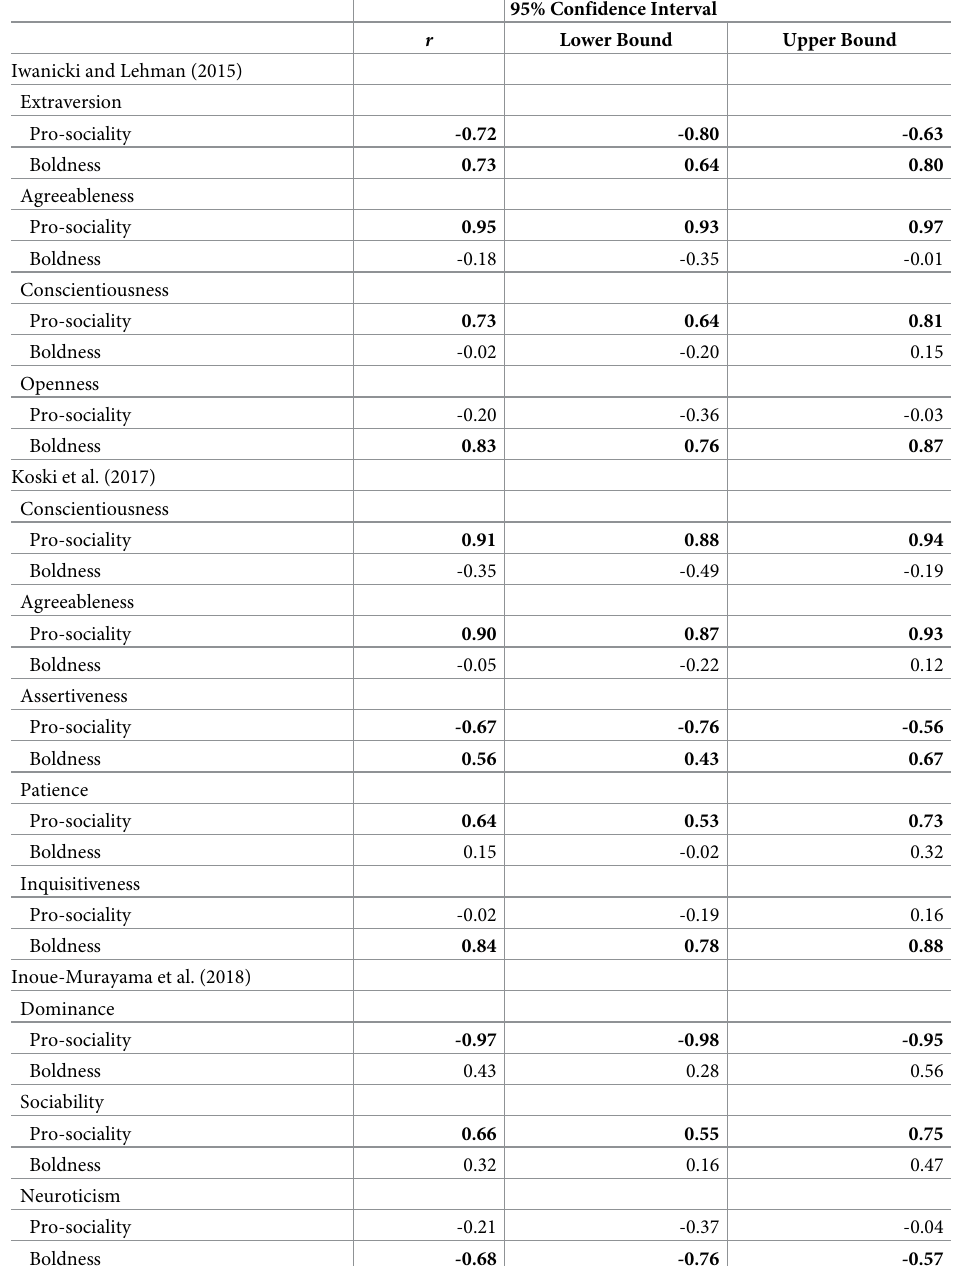
Table 7. Correlations between unit-weighted factor scores based on loadings from the second-order factor analy- sis in the present study and factor loadings from previous studies of common marmoset personality.